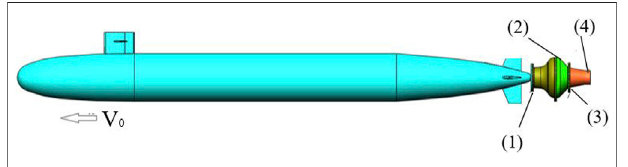
FIGURE 9 | Energy transfer model of water jet